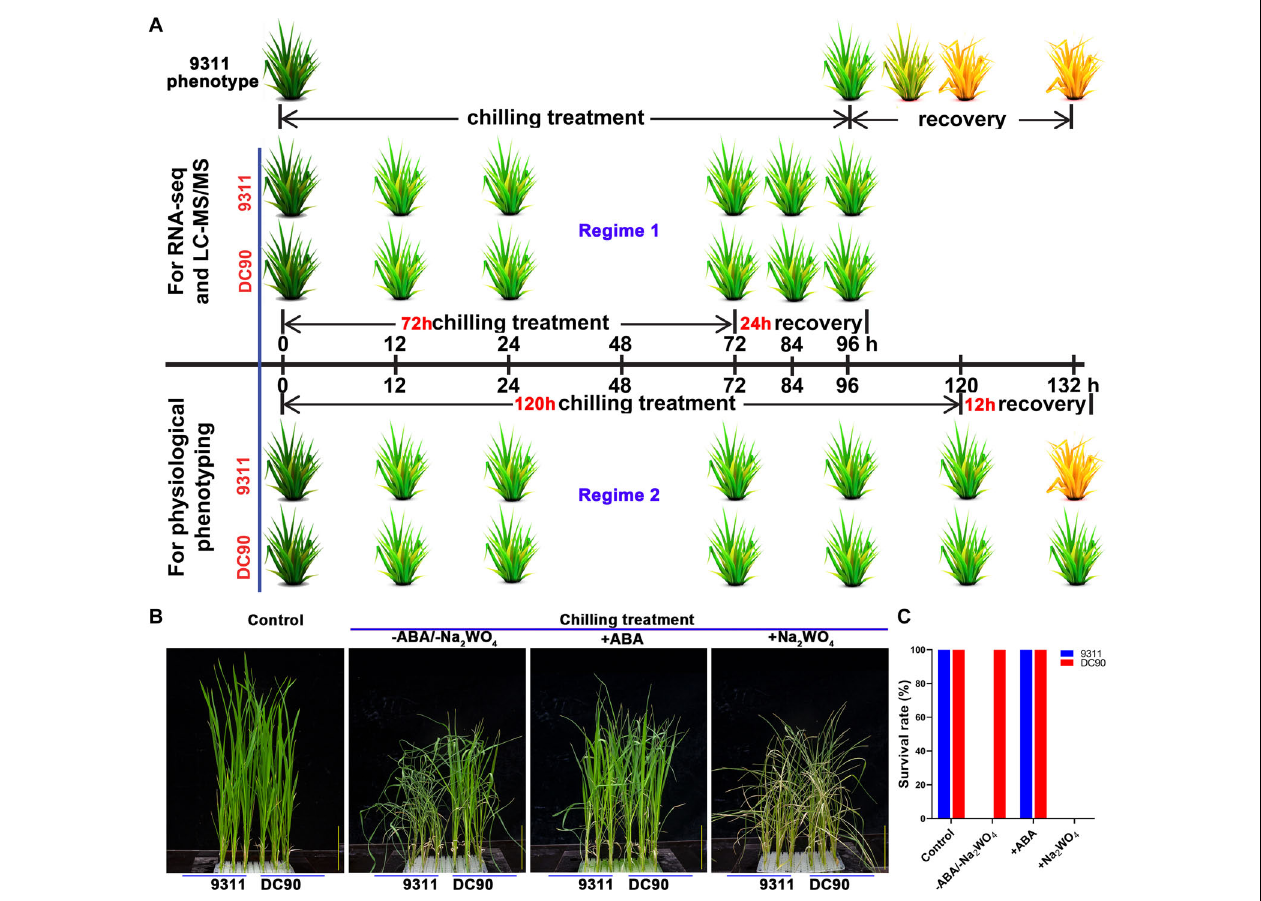
FIGURE 1 | Chilling stress phenotypes of 9311 and DC90 in response to exogenous application of ABA and its biosynthetic inhibitor, and diagram of the sampling and phenotyping timepoints. (A) Phenotyping and sample collection timepoints for RNA-Seq and LC-MS/MS, respectively. (B) Chilling stress phenotypes of 9311 and DC90 with exogenous application of ABA and its biosynthetic inhibitor Na 2 WO 4 . (C) Survival rate of 9311 and DC90 under chilling stress with/without exogenous ABA/Na 2 WO 4 application. Scale bars = 5 cm in (B) . Three biological replicates were